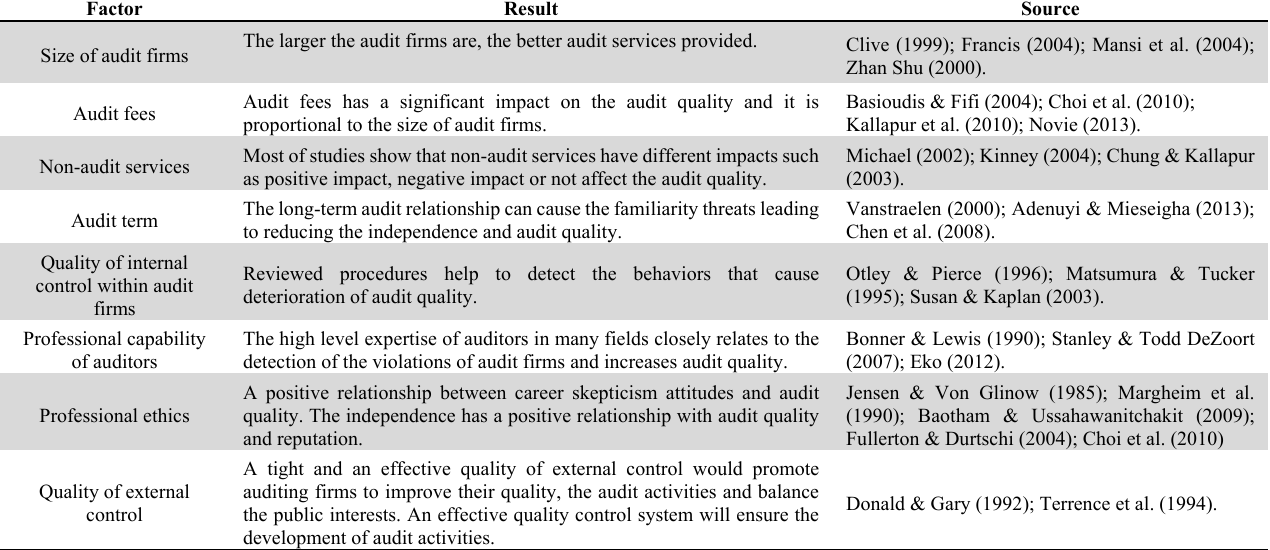
Summary of the audit quality factors based on the results of previous theoretical and empirical studies Factor Result